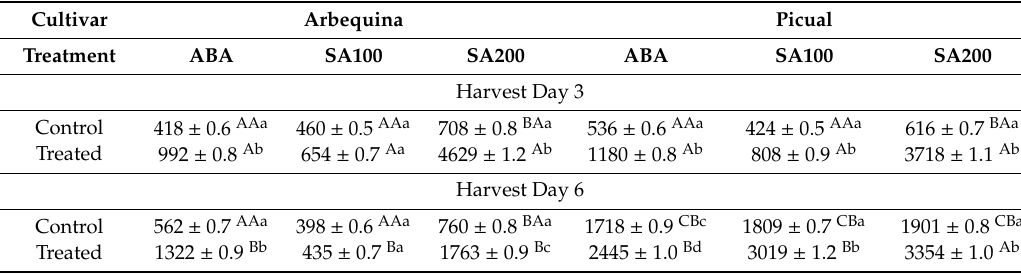
Data are presented as means resulting from three independent samples. Di ff erent superscript bold upper-case letters in the same row within the control samples and the same harvest day indicate di ff erences at p < 0.05. Di ff erent superscript normal upper-case letters in the same column between harvest days 3 and 6 within the same type of sample (control and treated), same treatment and same cultivar indicate di ff erences at p < 0.05. Di ff erent